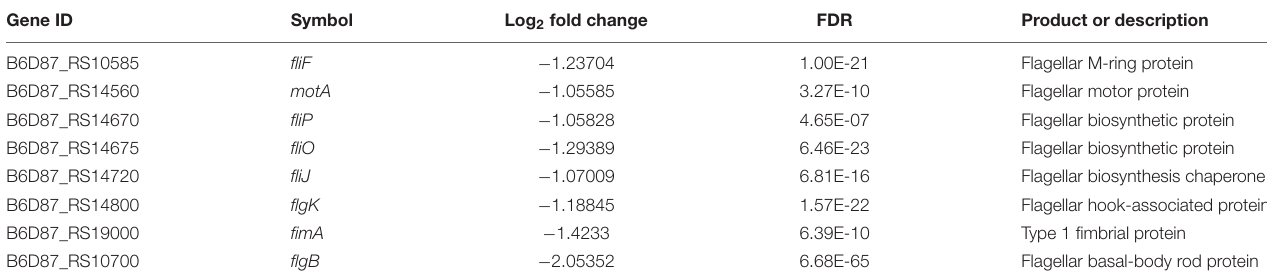
TABLE 2 | Differentially expressed genes related to motility and adhesion.